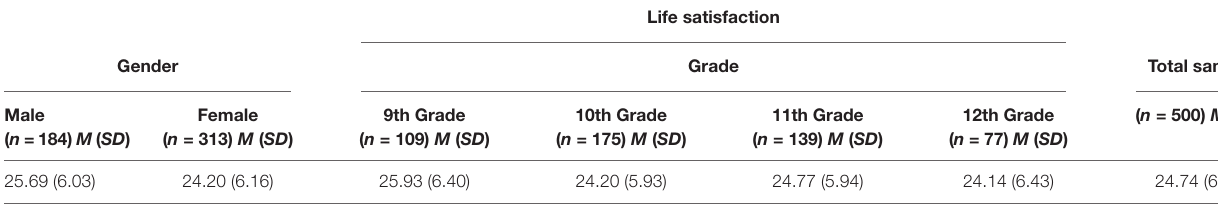
Life satisfaction